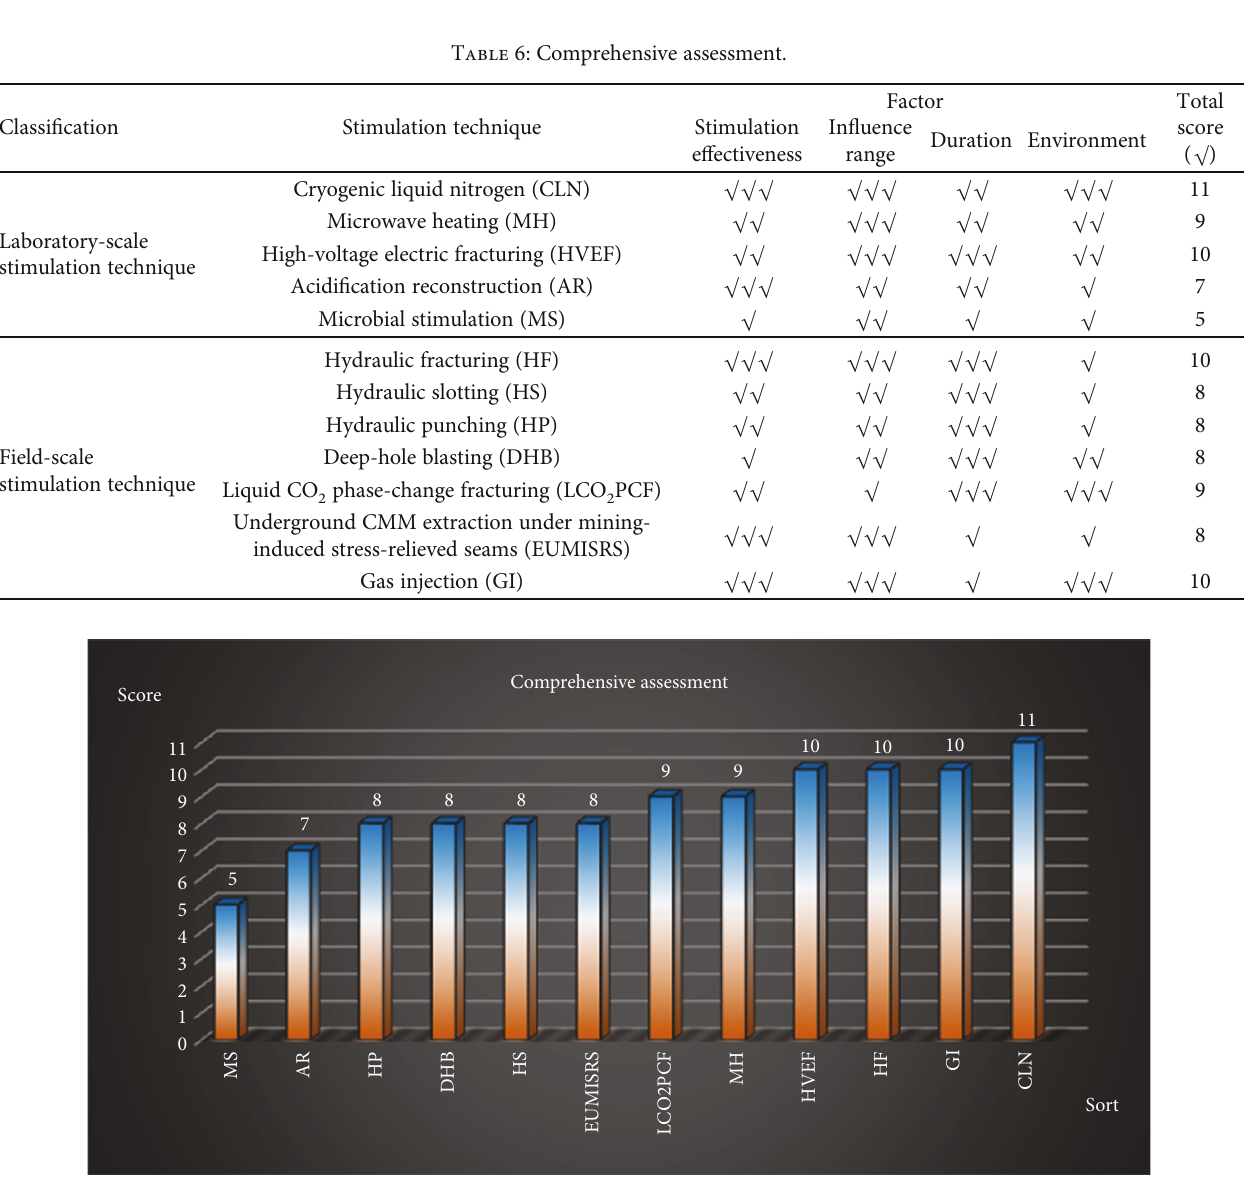
Figure 22: Comprehensive